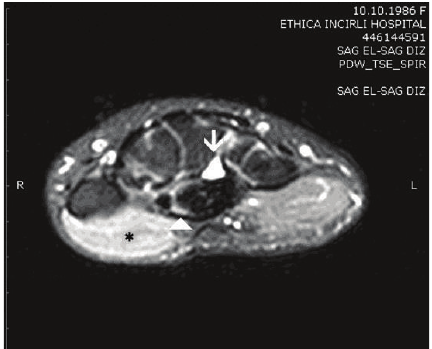
Figure 3: MRI revealed a space-occupying lesion (arrow) in the carpal tunnel and the median nerve (arrowhead) with high signal intensity and high signal intensity in the thenar muscles consistent with acute denervation (asterix) on fat-suppressed proton density axial images of the wrist.